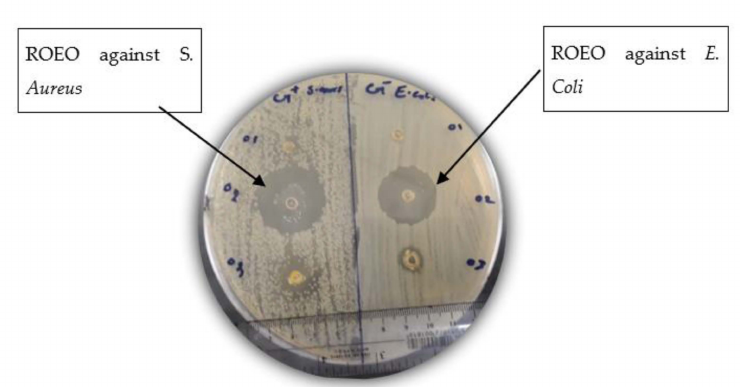
Figure 2. Inhibition zones of R. officinalis against S. aureus and E. Coli .